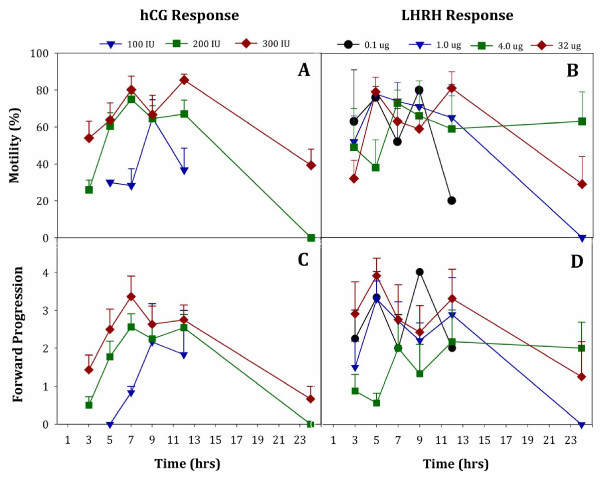
Percent sperm motility from male Anaxyrus americanus treated with either hCG (Panel A) or LHRH (Panel B) over time after administration with either: 100 (triangles), 200 (squares), or 300 (diamonds) IU hCG compared to 0.1 (circles), 1.0 (triangles), 4 (squares) or 32 (diamonds) μg LHRH. Forward Progression for these same sperm samples are shown in Panel C for hCG or Panel D for LHRH. Only one male American toad administered 50 IU hCG produced sperm for quality assessment and was not included in Panel A and C. Data are expressed as Mean ± SEM; lower SEM bars not shown. For number of animals comprising each treatment Mean see Figure 1.